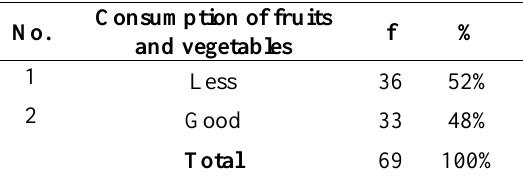
Table 2. Distribution of the respondents based on fruits and vegetables consumption